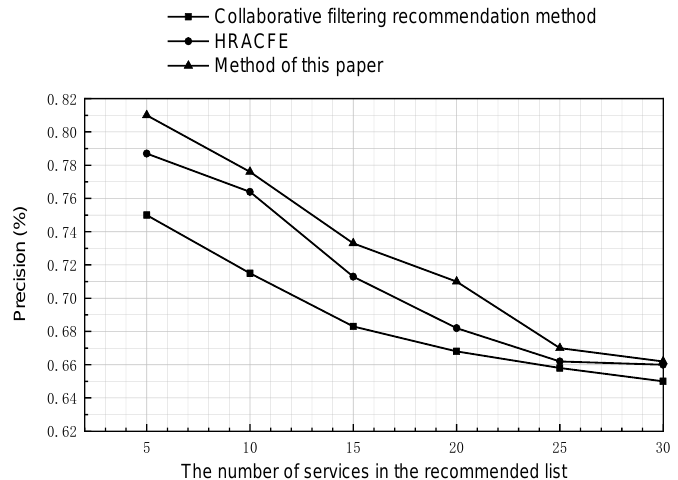
Figure 7. Precision comparison of different recommendation methods.